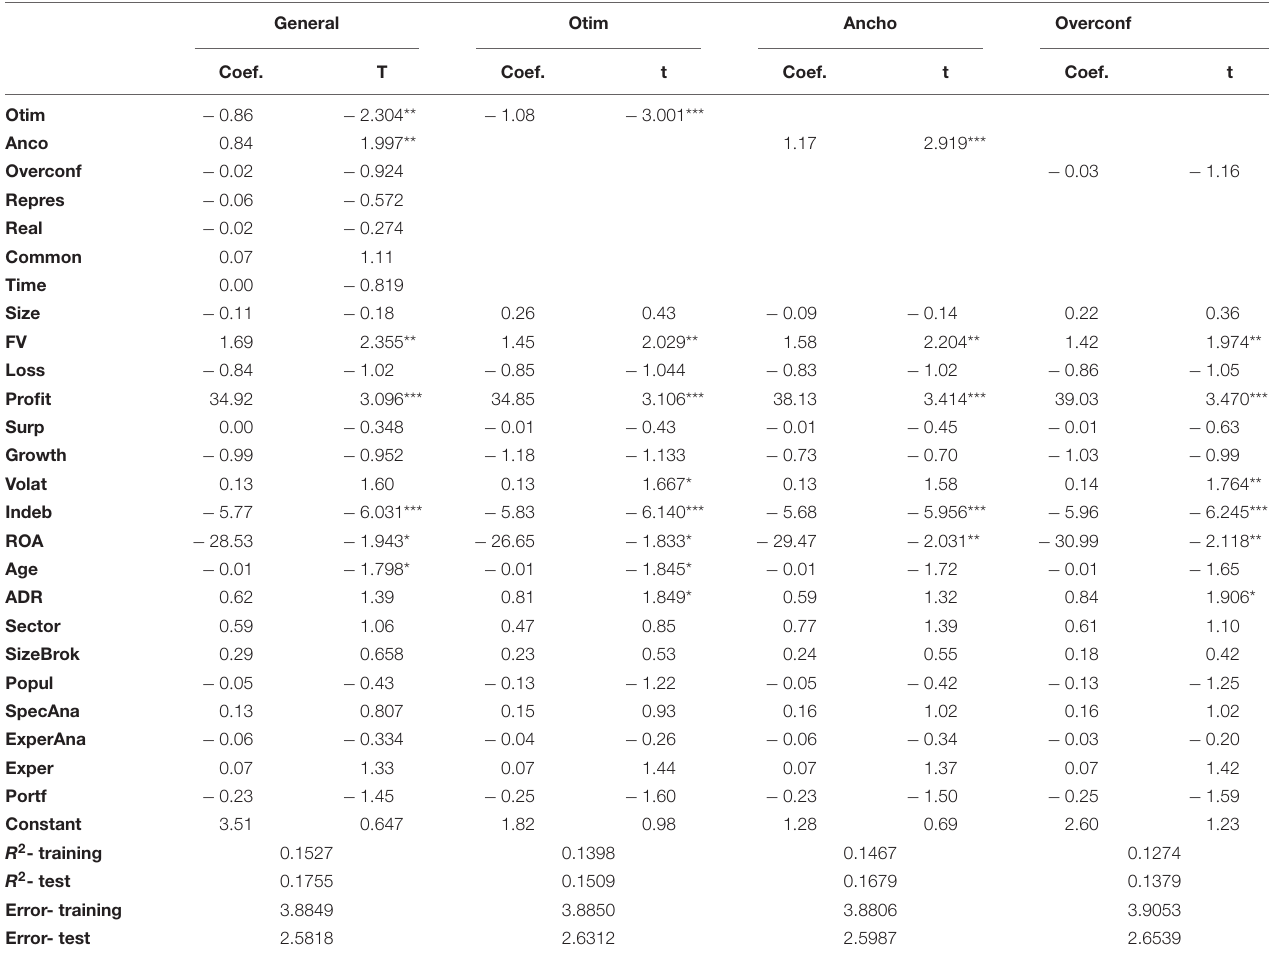
TABLE 3 | Regression in Ordinary Least Squares (OLS), carried out in the Caret package, for 2019. General Otim Ancho Overconf Coef. T Coef. Coef.